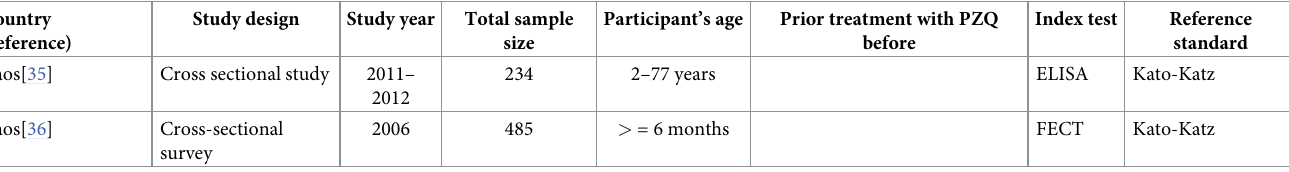
Table 2. Characteristics of included studies for S . mekongi